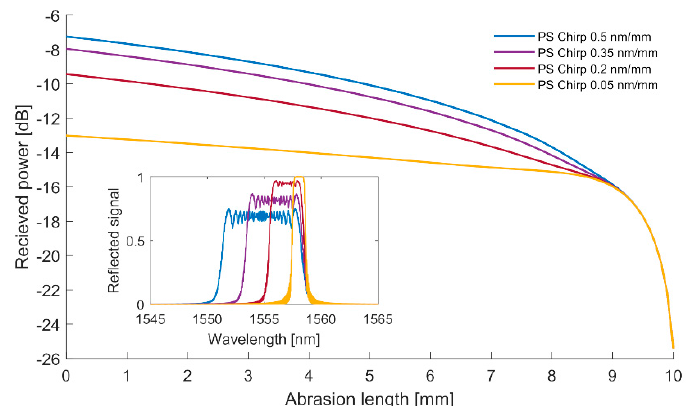
Figure 3. Received power versus the length of the grating for several values of fringe pattern chirp of the gratings. The central wavelength of the SLED corresponds to the center of the Bragg grating reflection. Initial Bragg grating length, of which the spectral response is presented in the inset graph, is assumed to be 10 mm.